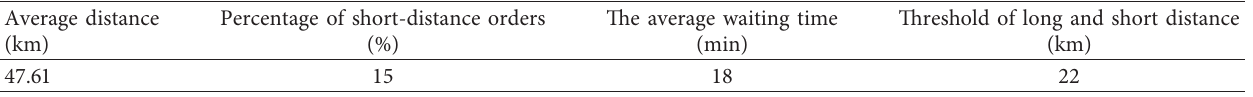
Table 16: The optimized calculation results from the airport to urban areas in workdays.